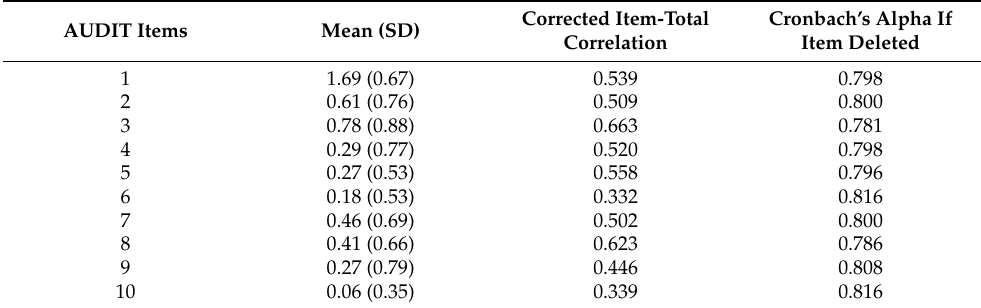
Table 2. Internal reliability of AUDIT online questionnaire administered in the UNIVERSAL sample ( n =